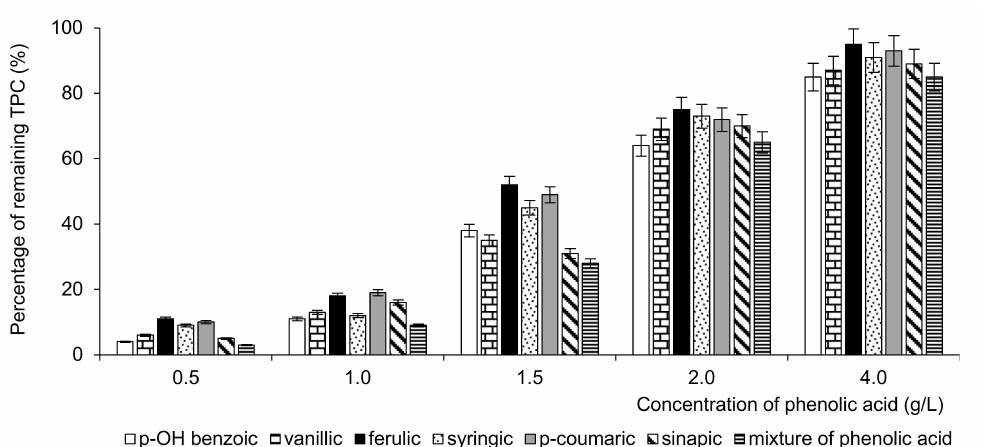
Figure 4. Percentage of undegraded TPC in